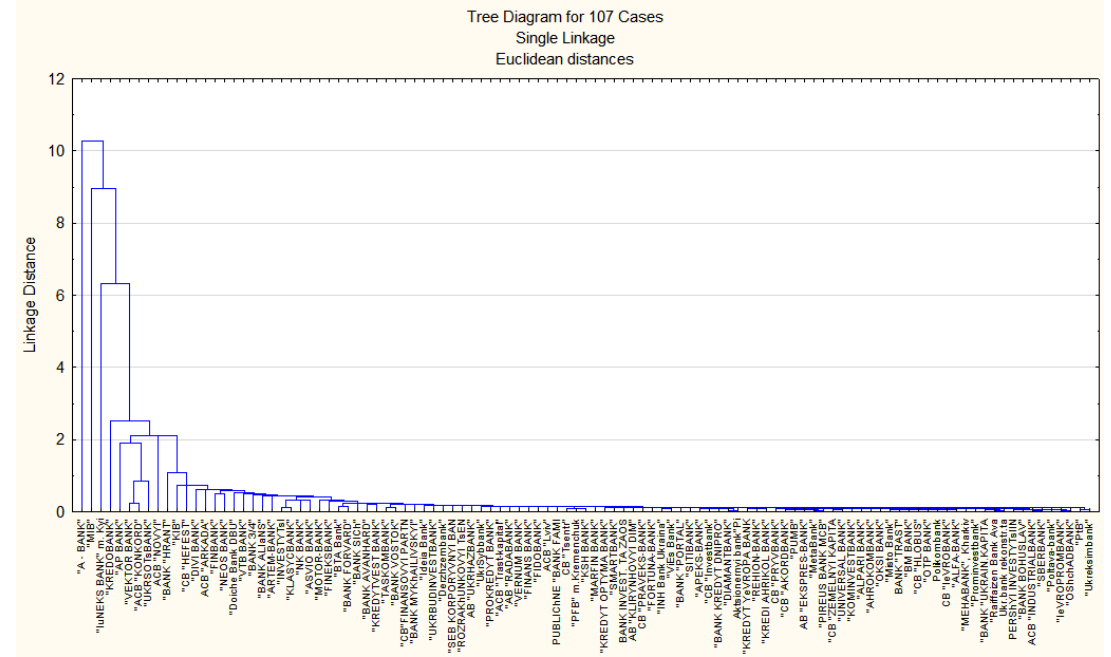
Fig. 1. The results of clustering Ukrainian banks using the Ward’s method Source: elaborated by the authors.